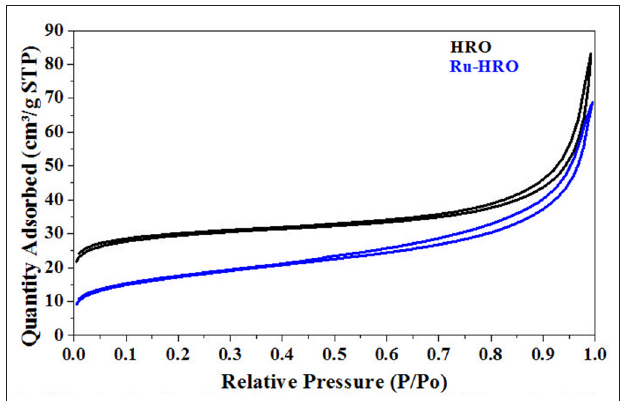
FIGURE 10 | N 2 absorption-desorption isotherms of HRO and Ru-HRO-1 (Recovered material from Table 1 , entry 10).